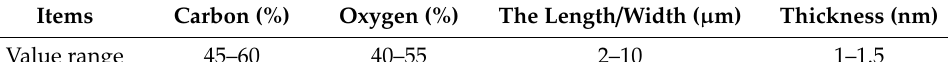
Table 2. The composition and dimensions of graphene oxide nanosheet.